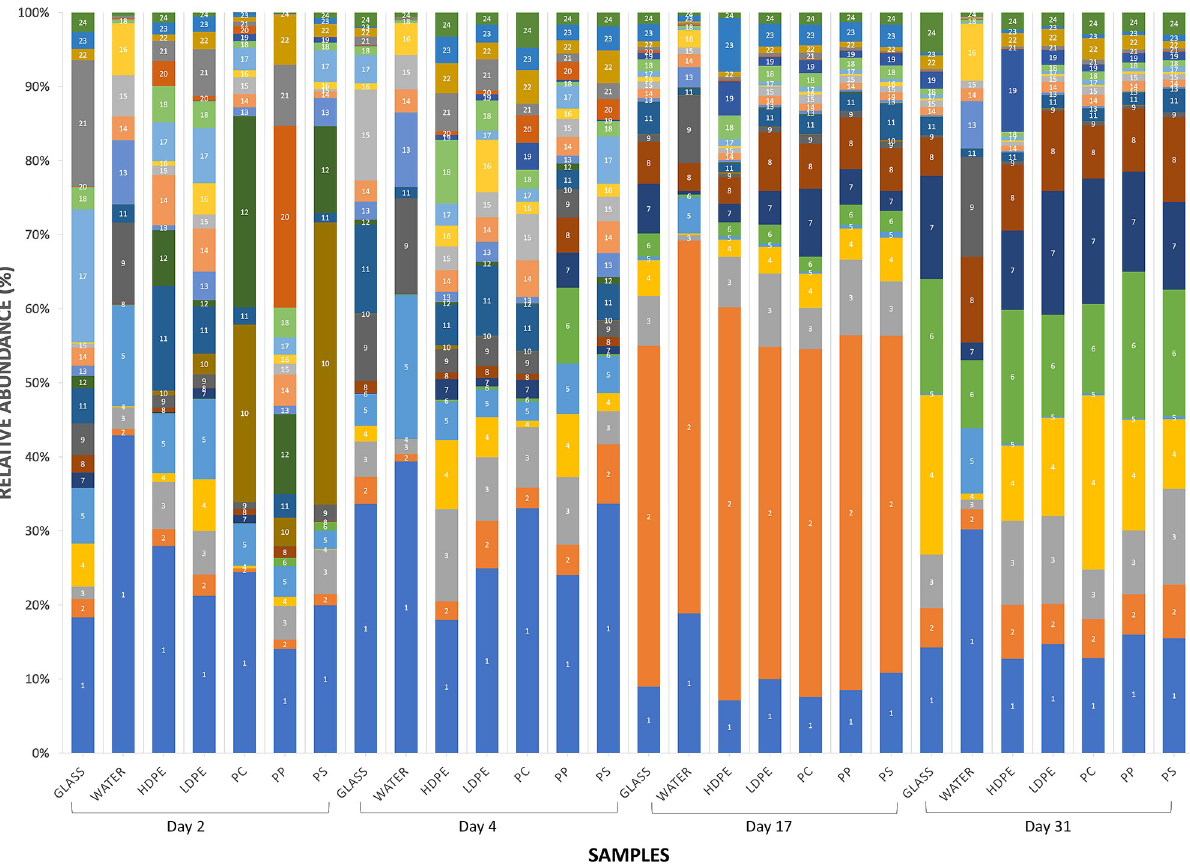
Fig 8. Relative abundances of sequenced Bacteria in Colonization Experiment #2. As in Fig 7, with the addition of polystyrene (PS) as a substrate and paired water samples. The most abundant OTUs are listed as follows: (1) Bacteria, Proteobacteria, Gammaproteobacteria,